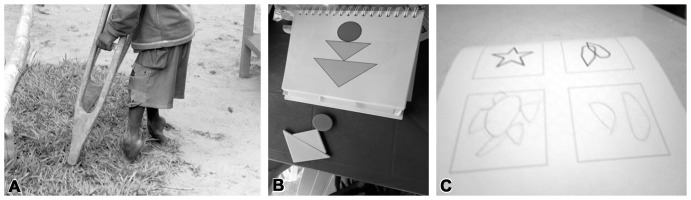
Illustrative example of neurodisability in konzo.(A) Spastic stance in a boy severely affected by konzo. (B) Depiction of deficits at KABC-II cognition testing. (C) Deficits in fine motor control at the BOT-2 testing.